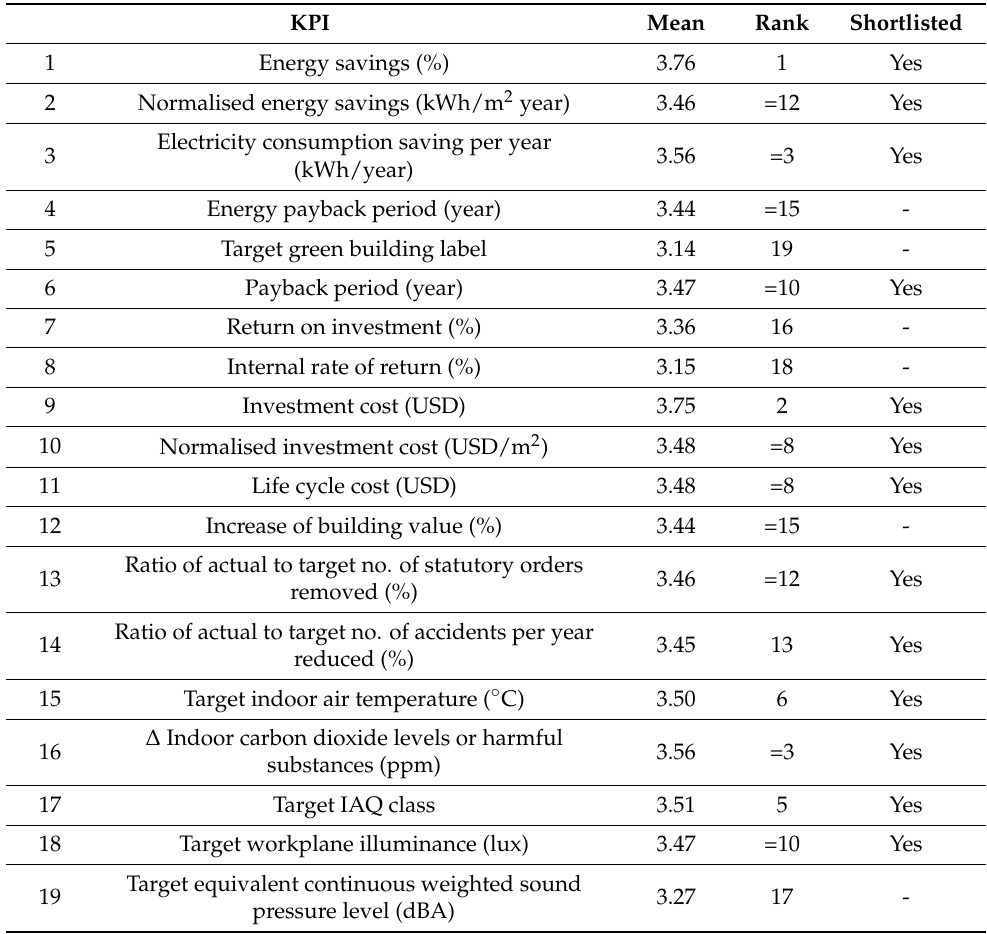
Table 4. Mean importance ratings and ranks of